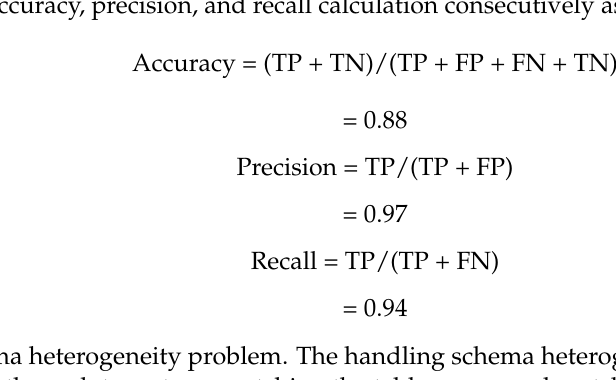
Table 5. Calculation TP, TN, FP, and FN in handling mismatch entity naming. A split-match-merge method with a multi-matcher algorithm